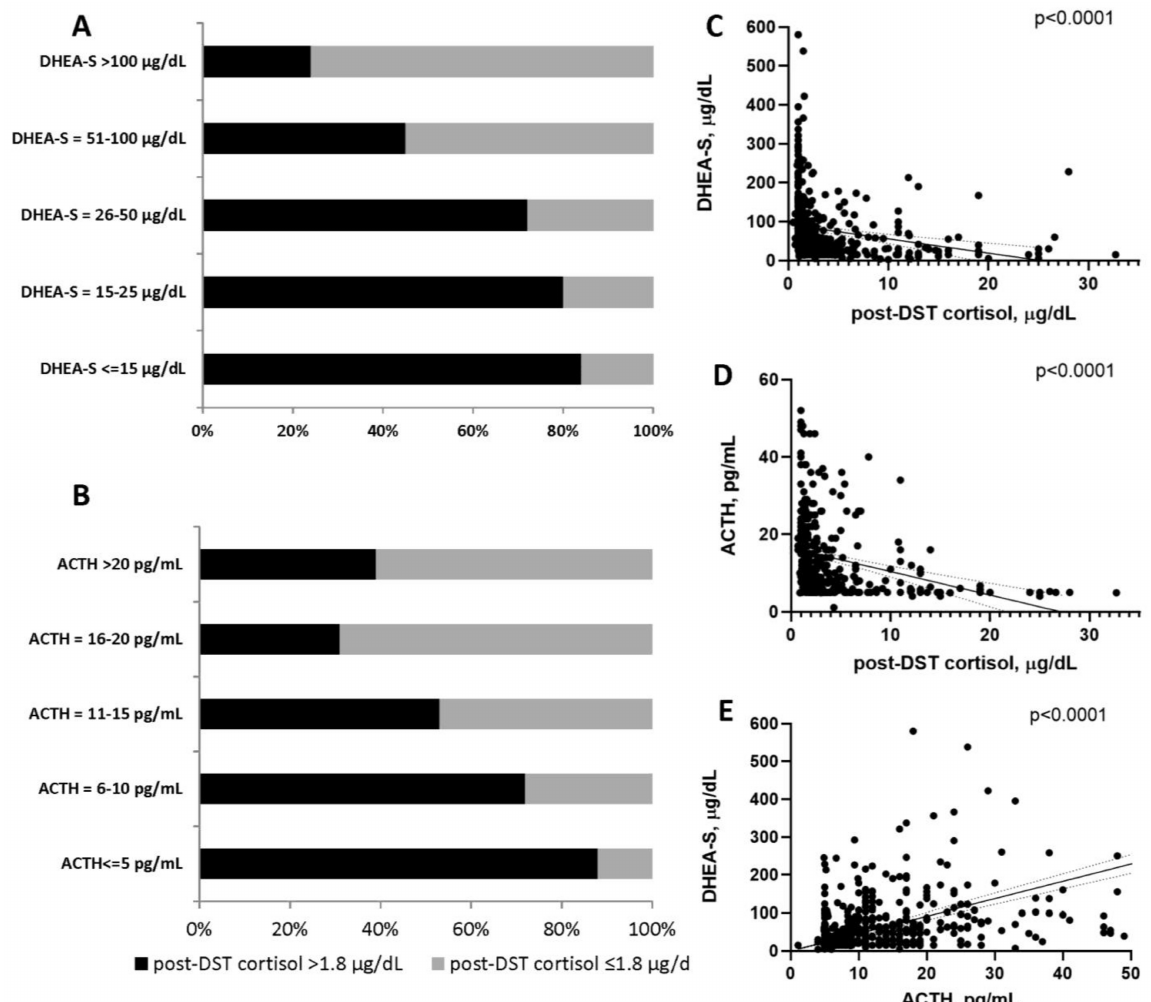
Figure 2. ( A ) Comparison of serum DHEA-S concentrations to 1-mg overnight dexamethasone suppression test (DST) results for post-DST serum cortisol concentrations of ≤ 1.8 versus >1.8 mcg/dL; ( B ) Comparison of serum ACTH con- centrations to 1-mg overnight dexamethasone suppression test (DST) results for post-DST serum cortisol concentrations of ≤ 1.8 versus >1.8 mcg/dL. of what is contained in the second panel. ( C ) Association between serum DHEA-S concen- tration and post-DST serum cortisol concentration. ( D ) Association between serum ACTH concentration and post-DST serum cortisol concentration. ( E ) Association between serum DHEA-S and ACTH concentrations. Abbreviations: ACTH, corticotropin; DHEA-S, dehydroepiandrosterone sulfate; DST, dexamethasone suppression test; ACS, mild autonomous cortisol secretion; NFAT, nonfunctioning adrenal